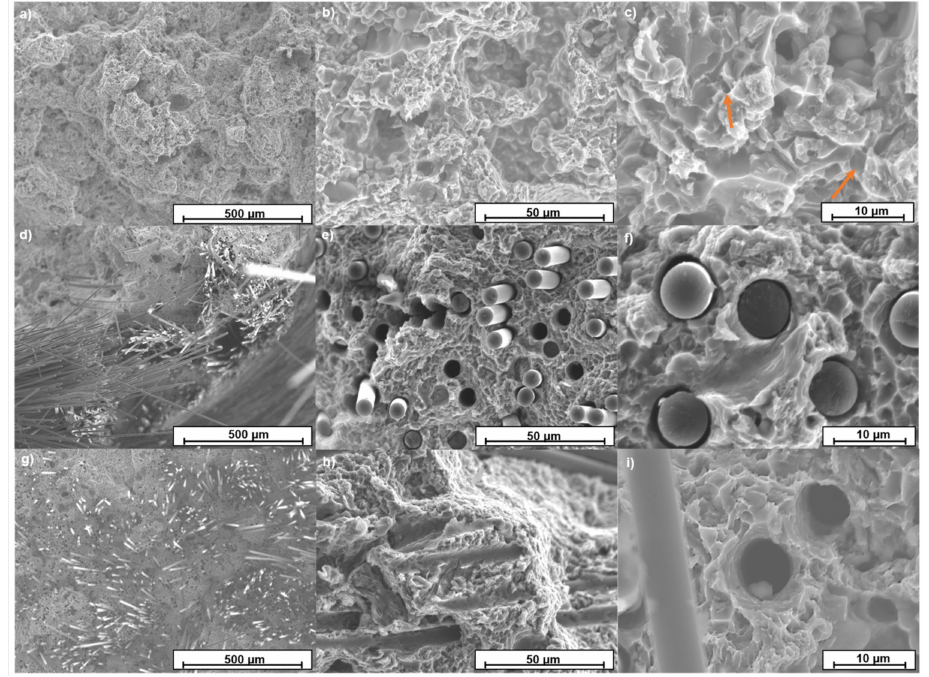
Figure 8. SEM fracture surfaces: ( a ) AA413 aluminum alloy and ( b , c ) magnification with dimples arrowed in orange; ( d ) aluminum reinforced with woven and ( e , f ) magnification of the extracted fibers; ( g ) aluminum reinforced with 0 ◦ unidirectional fiber and ( h , i ) magnification of different